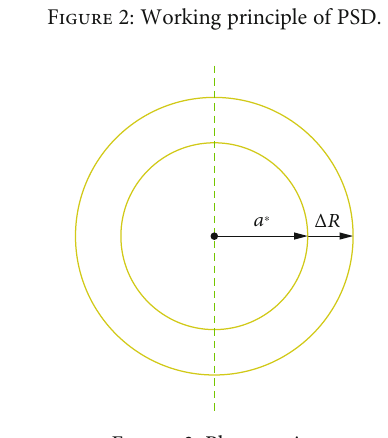
Figure 3: Plane strain.